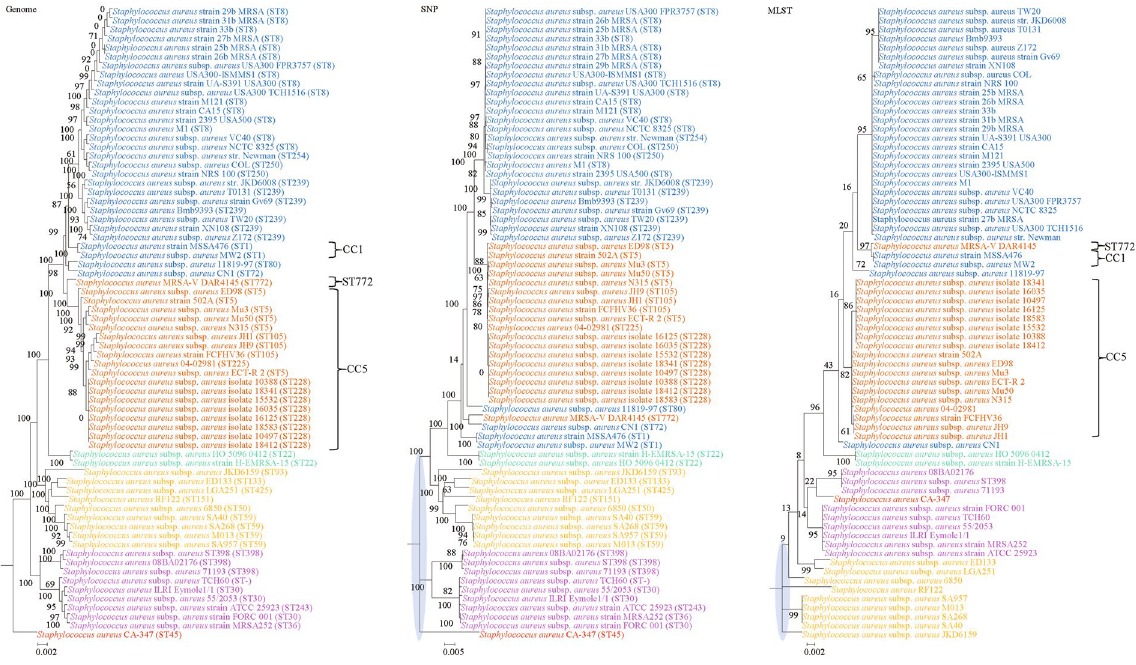
Figure 1. Comparison of phylogenetic trees constructed using genome data (left), SNP data (middle), and MLST data (right) for Staphylococcus aureus . Clusters that were manually selected based on the genome trees are illustrated in different colors. The unresolved polytomies are shaded in blue. A new sequence type is represented by a dash